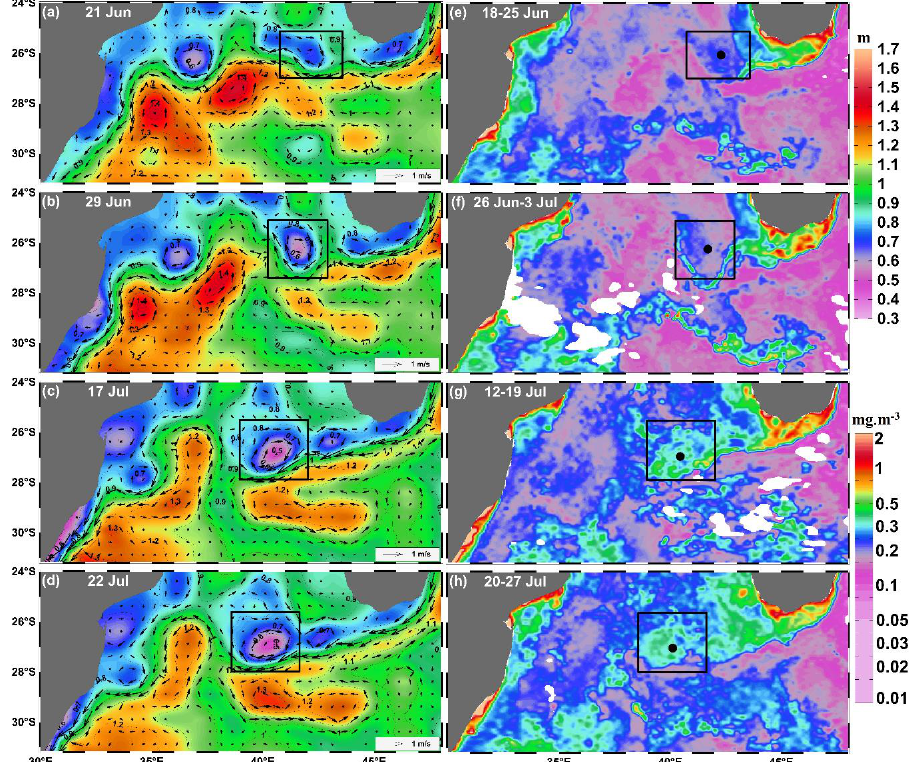
Figure 4. ( a – d ) Daily Sea Surface Height (colour contours) and geostrophic velocity (black arrows) on selected days for 21 June to 22 July 2013; and ( e – h ) 8-day MODIS Aqua chlorophyll a composites for 18 June to 27 July 2013, over the Mozambique Basin. Black boxes highlight the location of the cyclonic eddy and black dots indicate the centre of the eddy. White areas indicate missing data due to cloud cover.